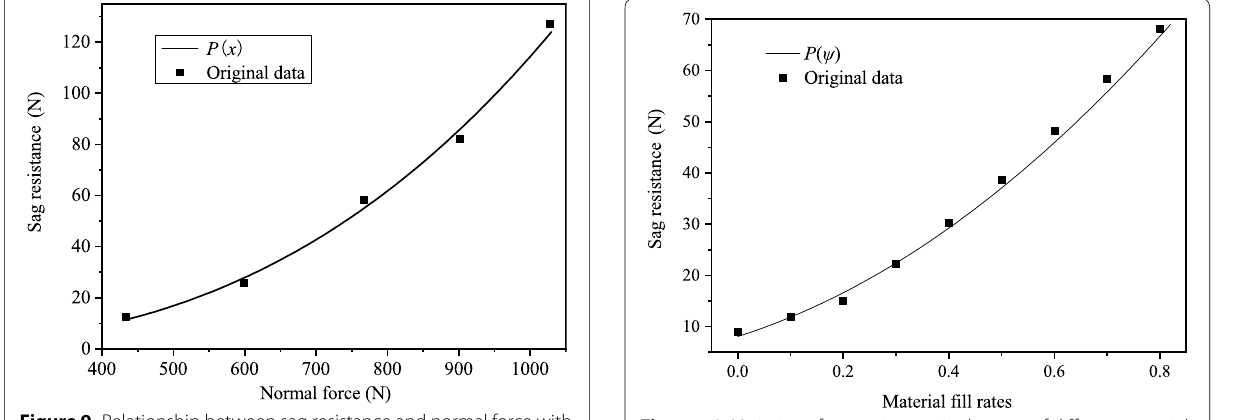
Figure 10 Variation of sag resistance in the case of different material filling